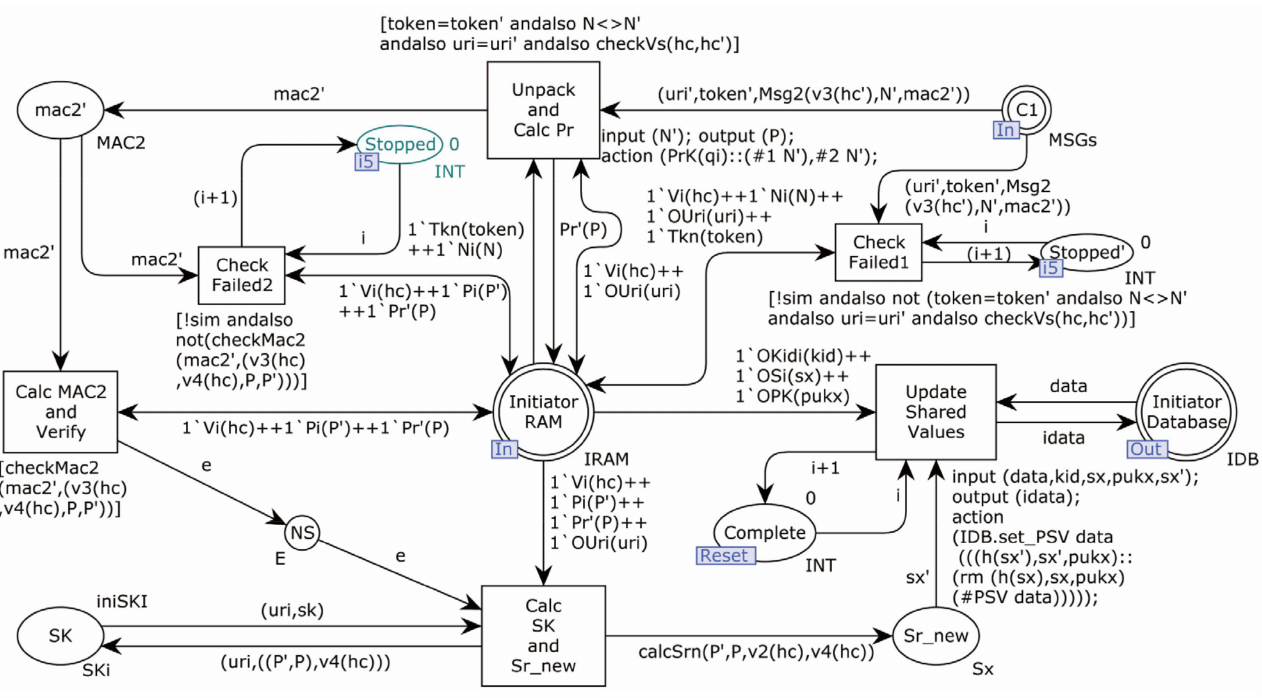
Figure 11. Initiator model sub-page OP